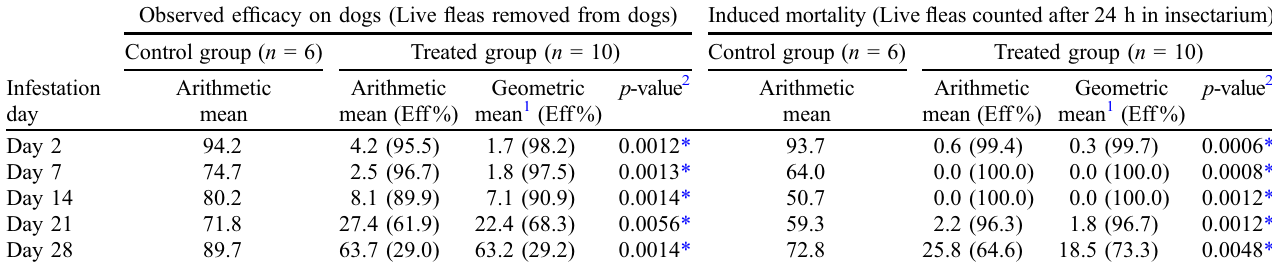
1 Computed as the anti-logarithm of the arithmetic mean of the log-counts and then subtracting 1. 2 (Two-sided) Probability value associated with the comparison of the population means of the two treatment groups. * Significant